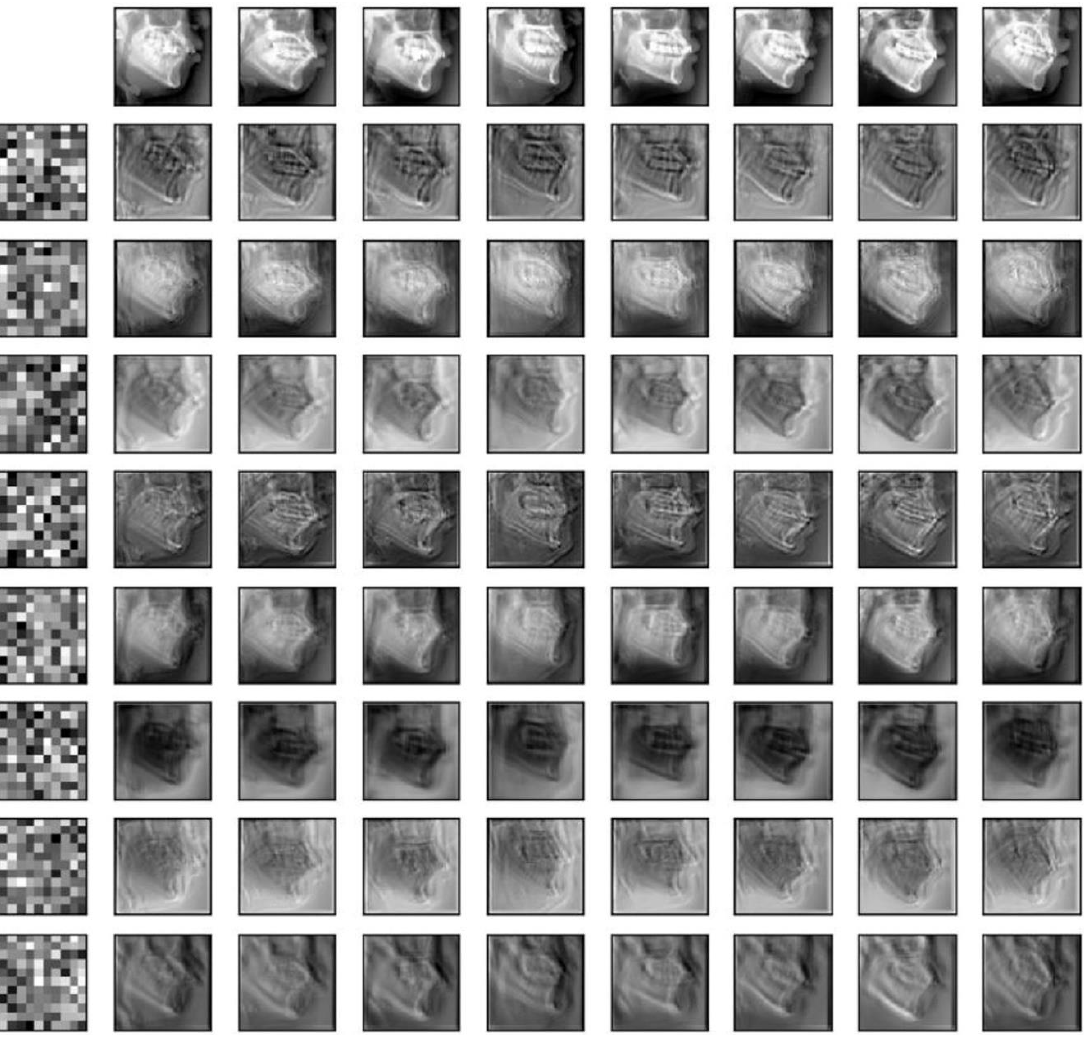
Figure 6. Extracted features after the original images (in the top row) passed the convolutional filters (in the left column) .